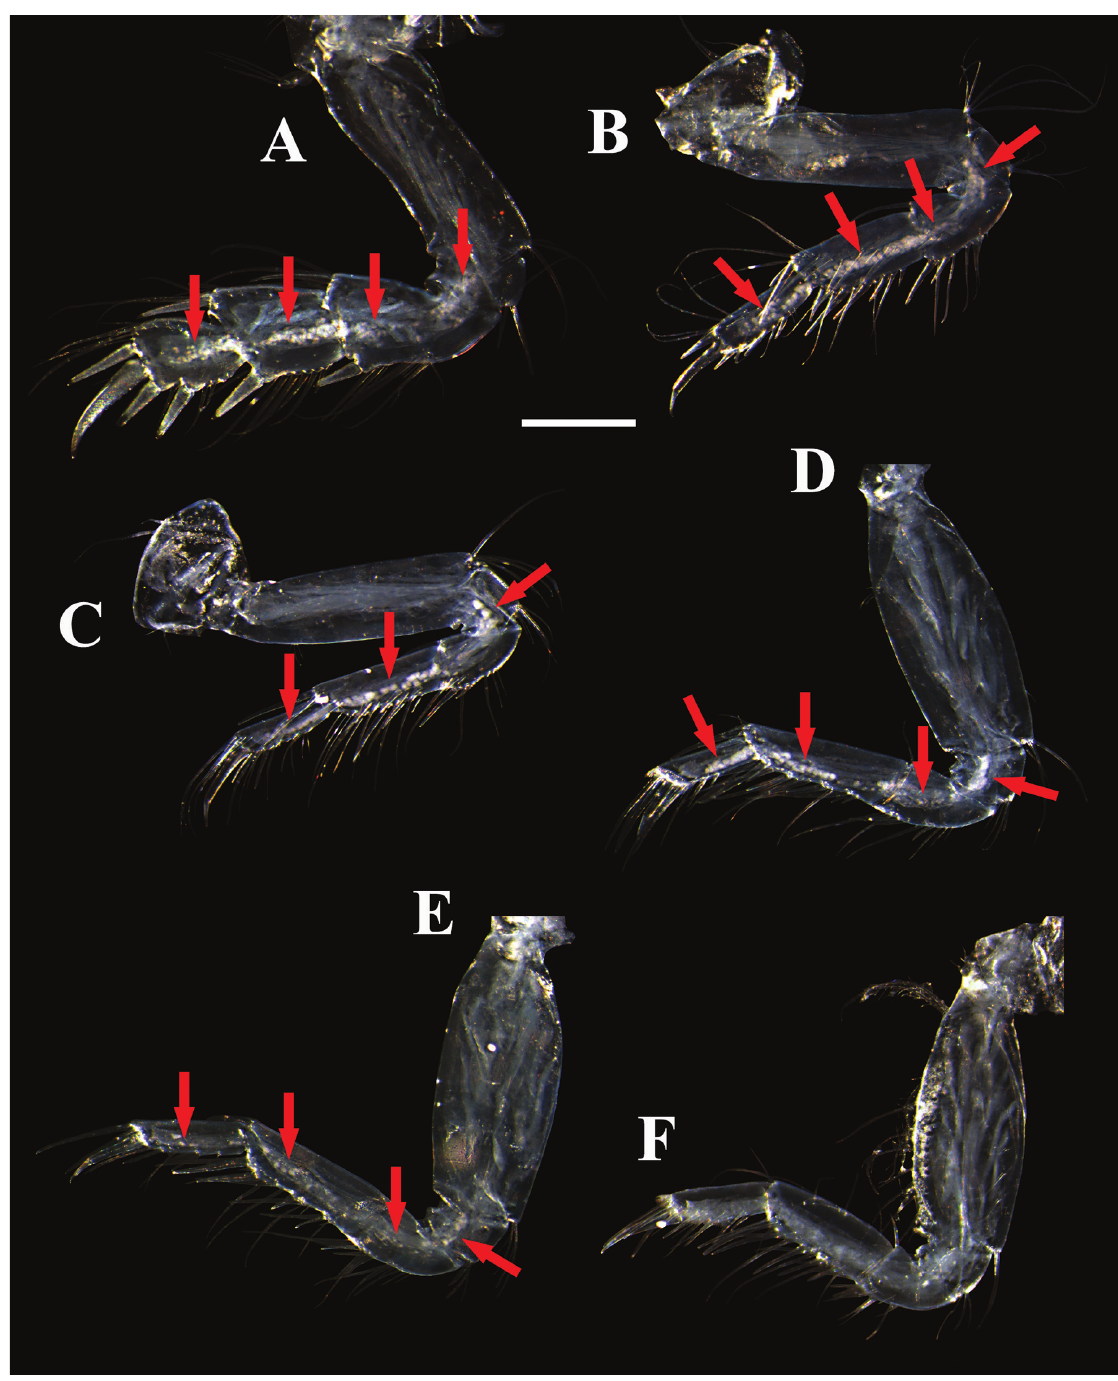
Figure 11. Digital images of Brachylicoa lui sp. n. paratype female with oostegites and genital cone (dissected). A − F pereopod 1−6. Arrows shown the presence of glands. Scale bar = 0.5